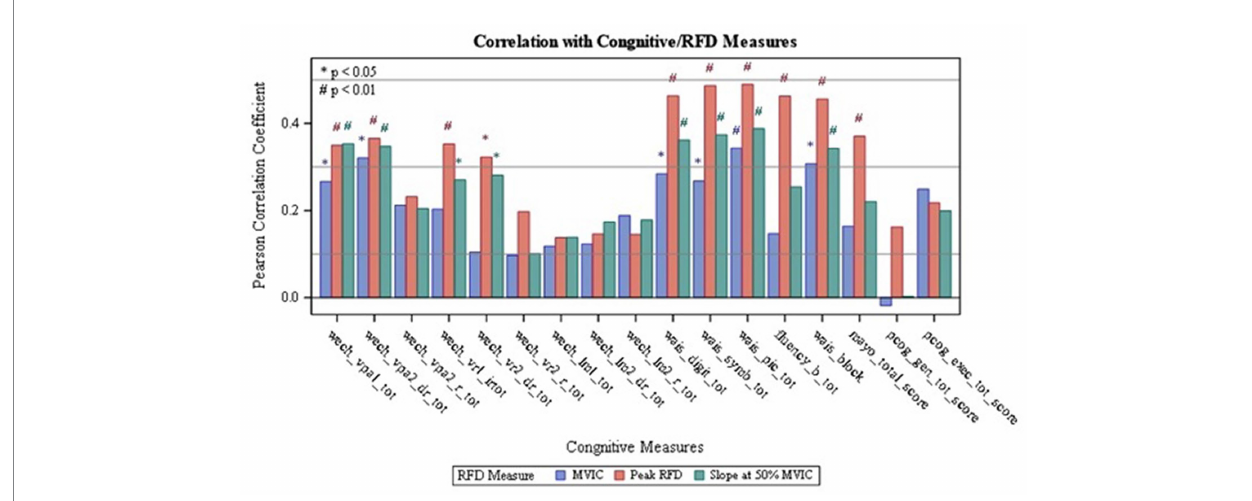
FIGURE 1 Correlation of Dominant RFD with Cognitive Measures: wech_vpal_tot — Total Visual Paired Associates I — Immediate Recall Raw Score; wech_vpa2_ dr_tot — Total Verbal Paired Associates II-Delayed Recall Raw Score; wech_vpa2_r_tot — Total Verbal Paired Associates II- Recognition Raw Score: